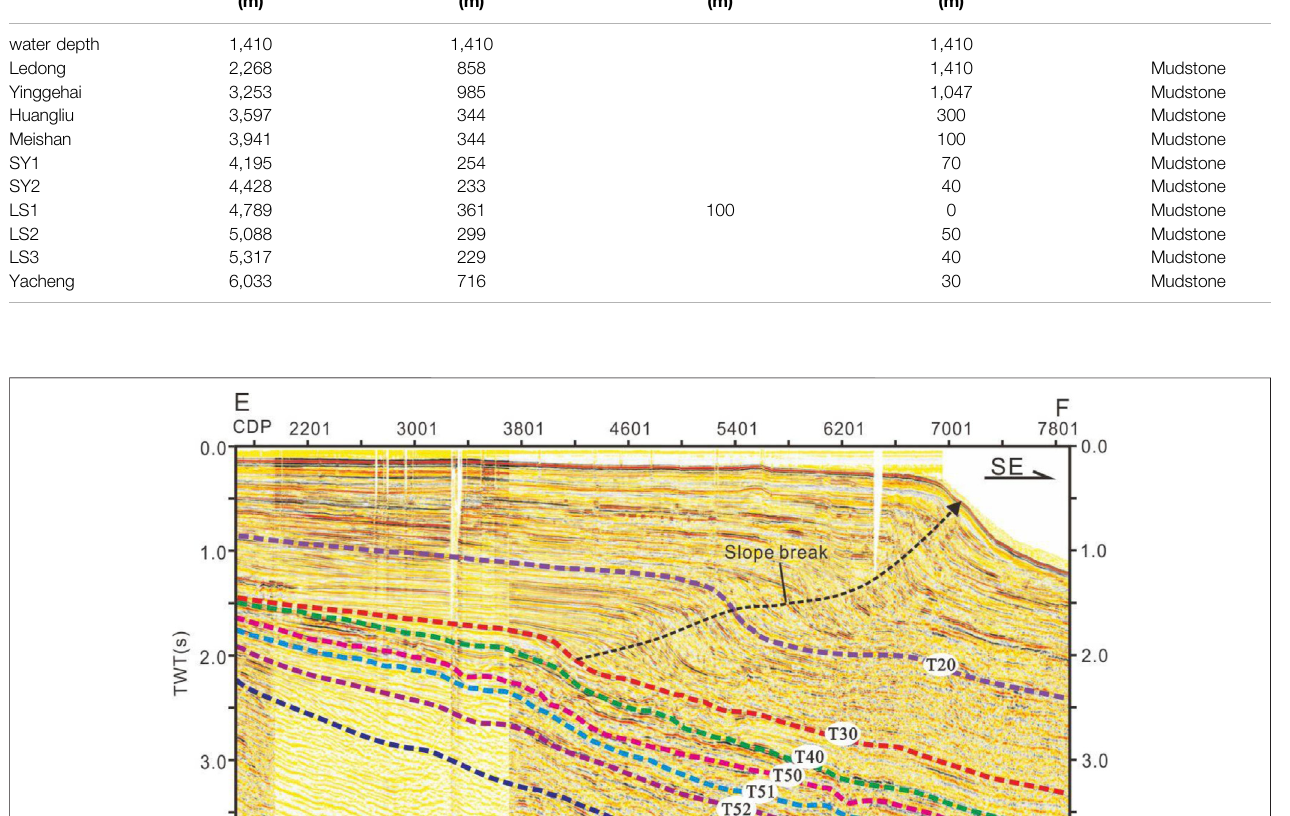
Frontiers in Earth Science |